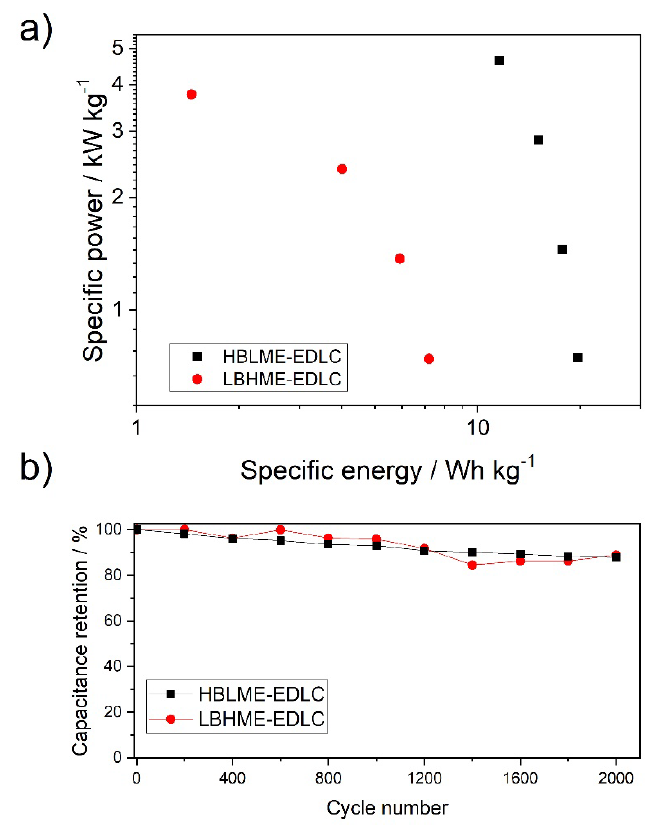
Figure 6. EDLC comparison by galvanostatic tests . ( a ) Trend of the capacitance percentage normalized by the value at first cycle the as function of the cycle number (at 1 A g − 1 , cell voltage cut-off: 0 V–3.2 V) and ( b ) Ragone plots of HBLME-EDLC and LBHME-EDLC.